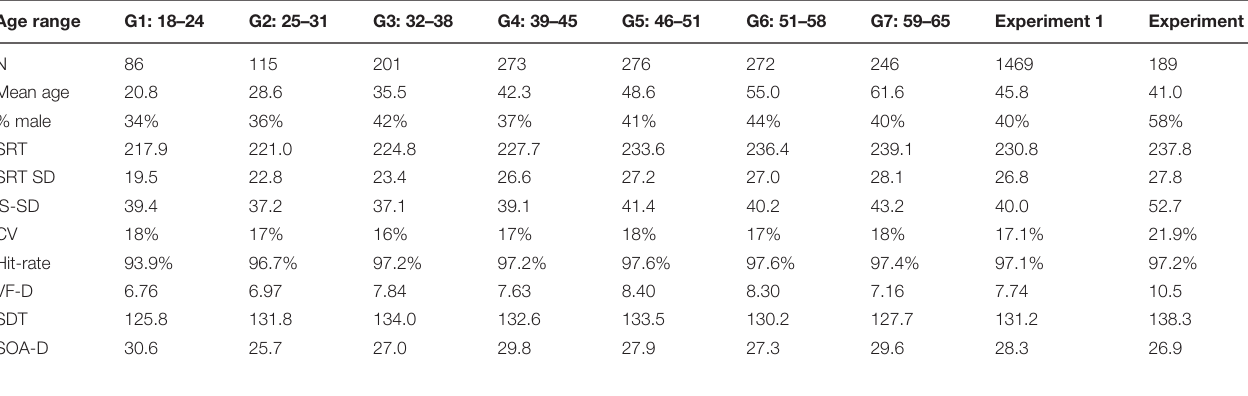
VF-D, absolute difference in SRTs for stimuli in the left and right visual fields; SDT, stimulus detection time (the difference between SRT and movement initiation time measured in a finger tapping task); SOA-D, difference in SRTs following short (1000 ms) and long (1800 ms) SOAs. Physical calibration suggests that “true SRTs” are reduced by 18 ms and SDTs by 11 ms. See Table 1 for descriptions of additional